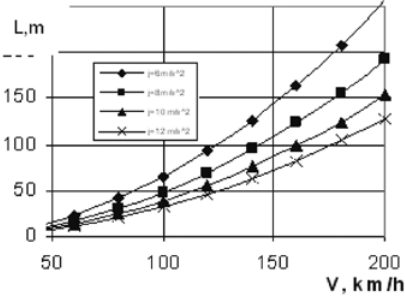
Fig. 5. Dependence of the length of the horizontal part on the speed of